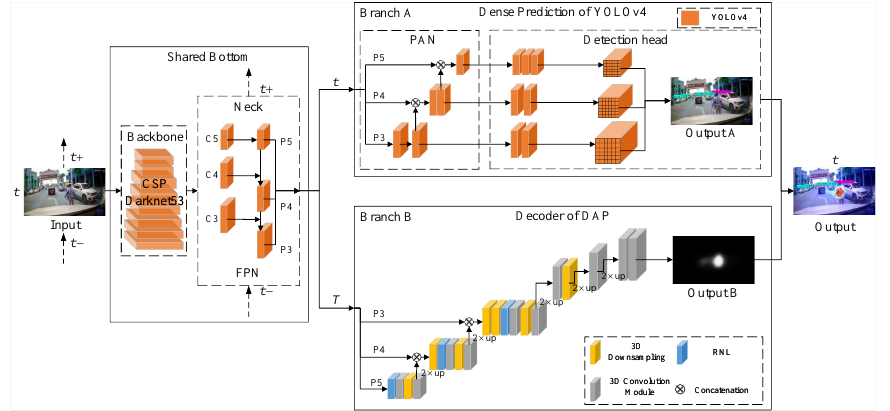
Figure 6. Overview of SOE-Y, where t denotes the current frames, t − represents the historical frames, t + denotes the future frames, and T represents the number of consecutive frames. C ∈ { C 3, C 4, C 5 } and P ∈ { P 3, P 4, P 5 } represent different feature levels in